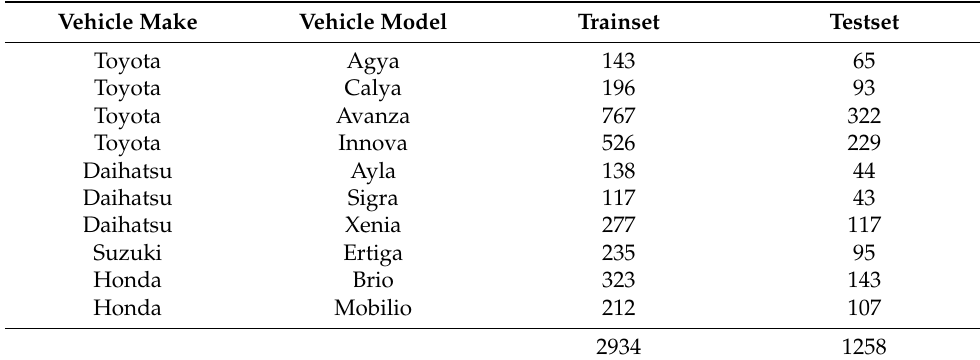
Figure 3. The five key points in the InaV-Dash Dataset. Table 1. InaV-Dash dataset in statistics.